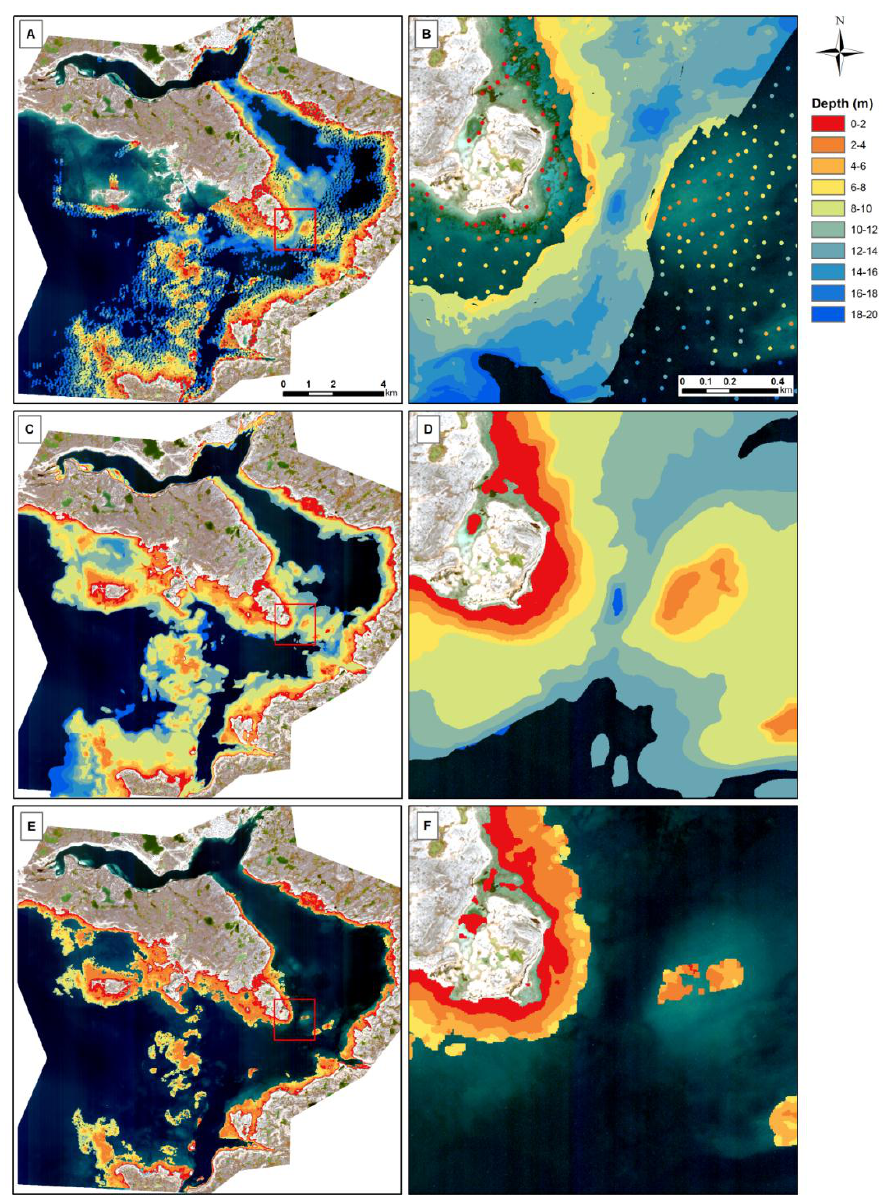
Figure 4. Comparisons between CHS survey data and stereo photogrammetry approaches for the entire WorldView-2 image and an inset area. ( A , B ): CHS survey data. ( C , D ): manual approach results. ( E , F ): automatic approach results. All share the same colour scheme shown in the legend. Imagery © 2015, DigitalGlobe,